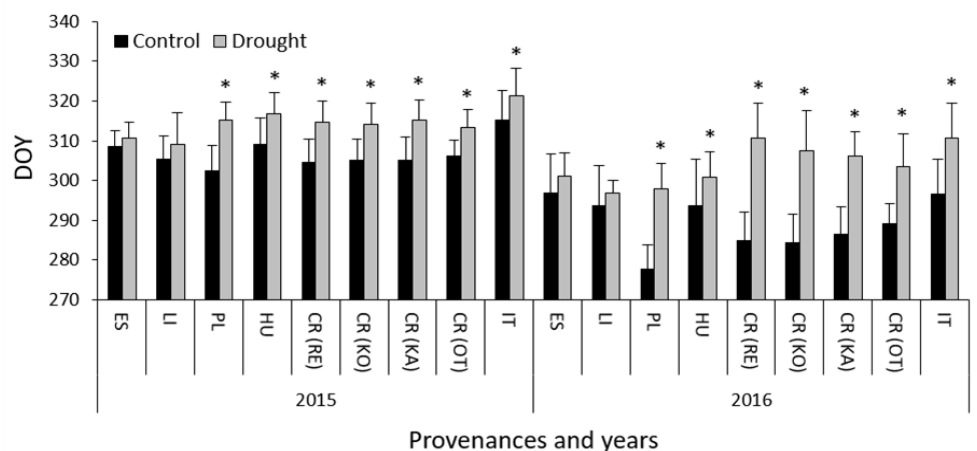
Figure 3. Provenance means of autumn leaf senescence in the treatments (control and drought) expressed as day of year (DOY) in 2015 and 2016. Vertical bars indicate the standard deviation of the mean values. Asterisks above bars indicate significant differences between treatments for the same